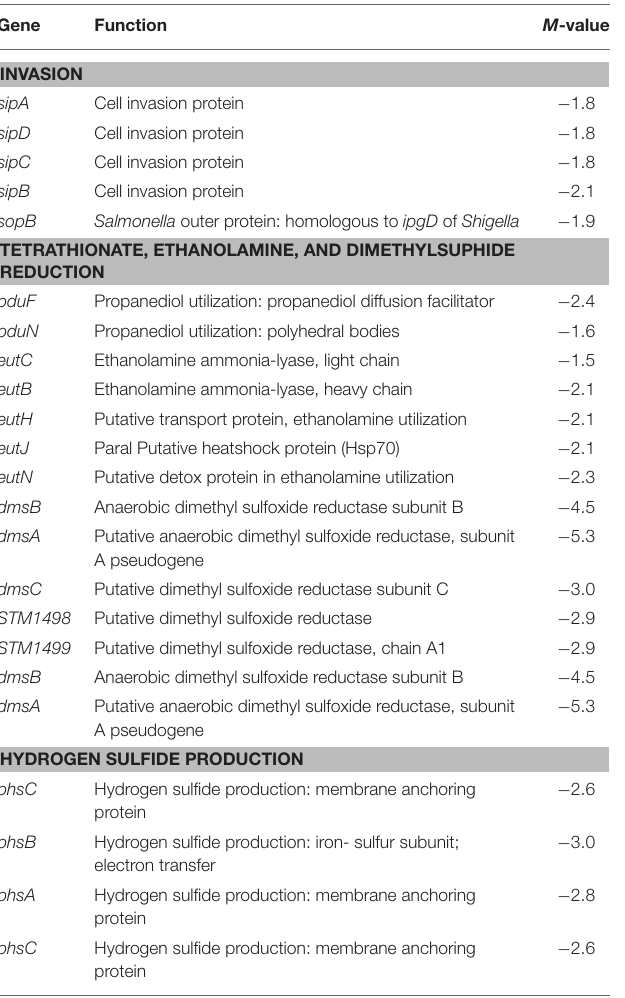
Flagellar biosynthesis; flagellin, filament structural protein − 2.2 Flagellar biosynthesis; possible export chaperone for FliD Flagellar biosynthesis, hook-filament junction protein 1 Flagellar biosynthesis; hook-filament junction